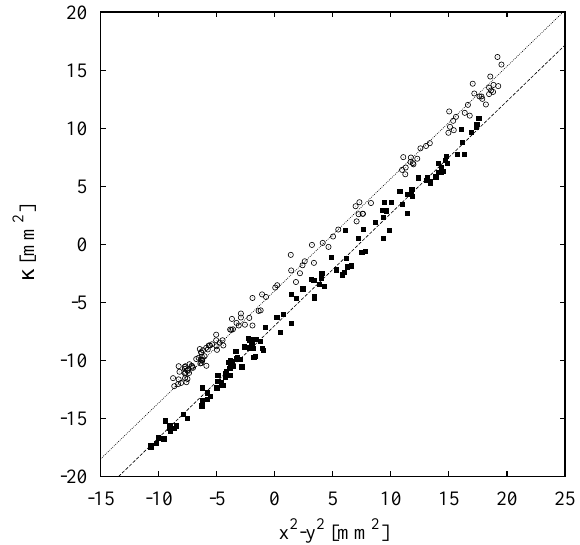
FIG. 3. Quadrupole moment (uncorrected) versus expected beam position contribution. The squares and circles represent measurements made with the same pickup on two different beams. The slope of the line is the same in both cases and is very close to 1